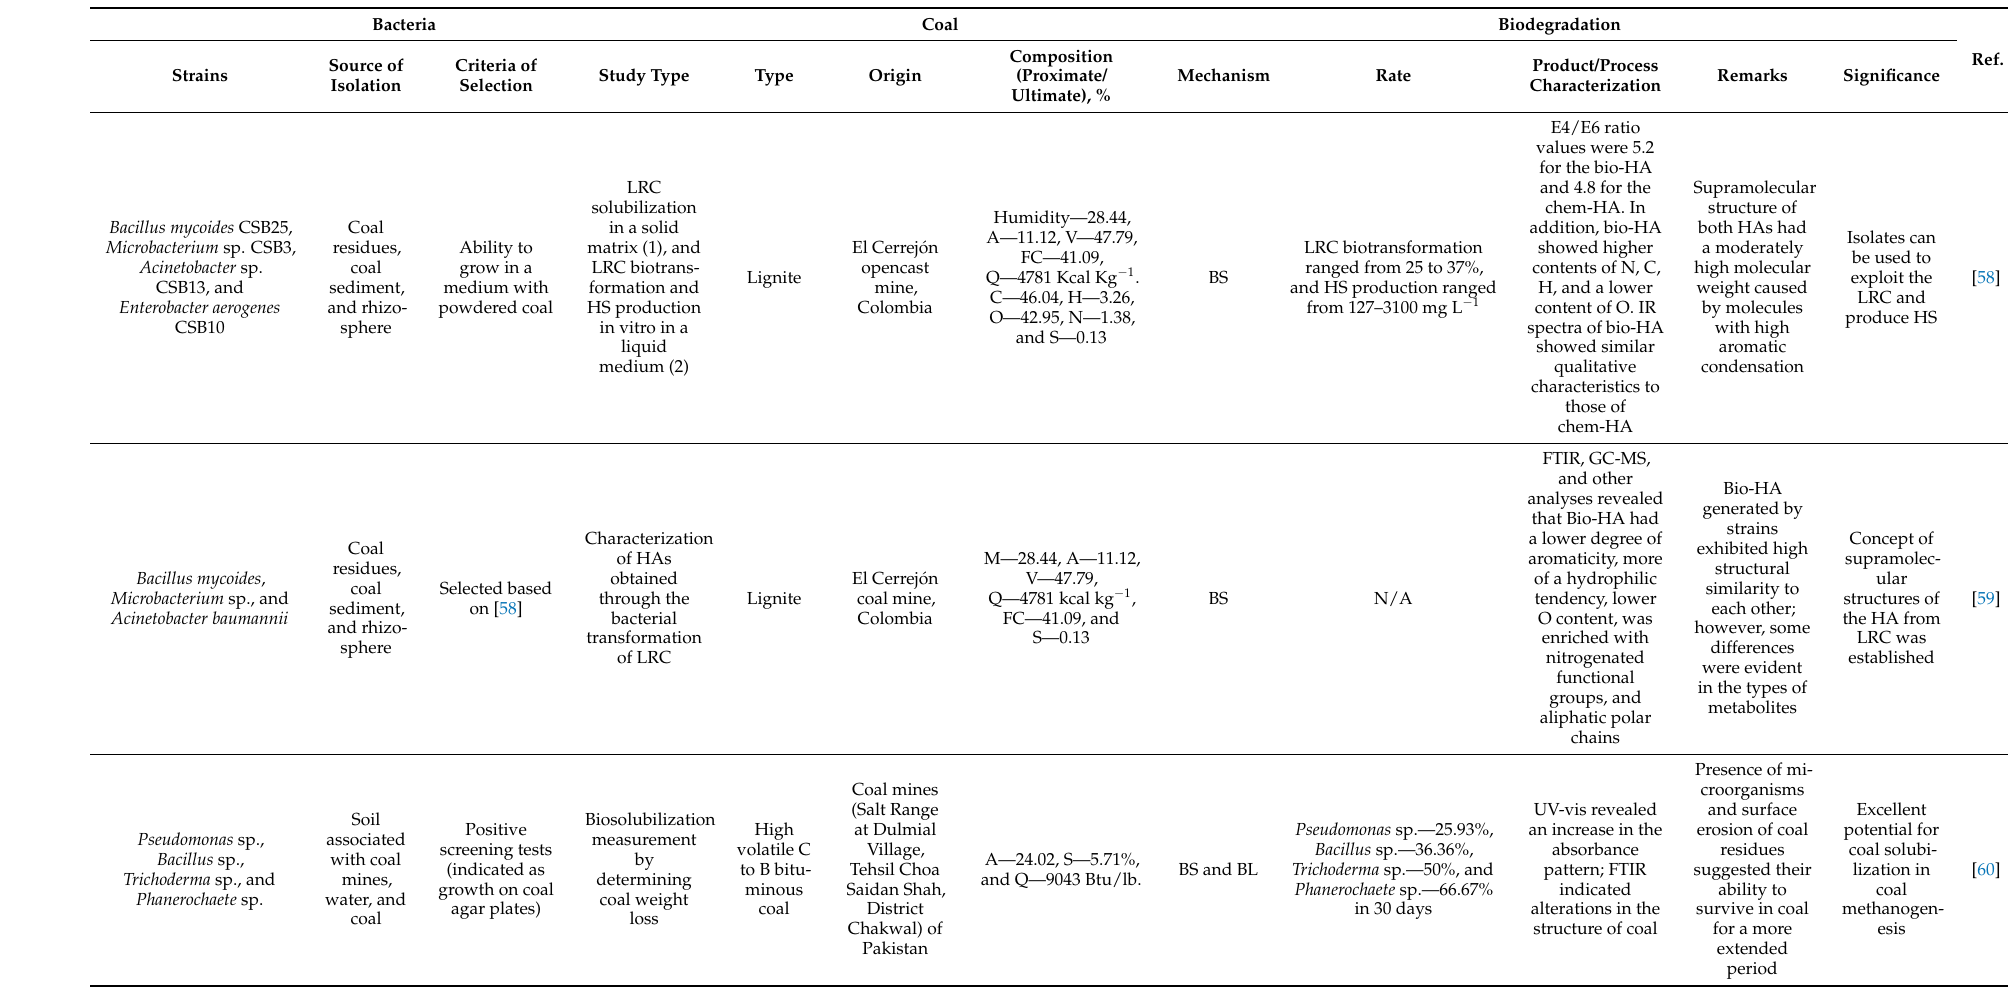
Table 2. Biodegradation of various coal sources through native consortia of bacteria: understanding the mechanisms, rates, and characterization of coal biodegradation is fundamental in the context of coal utilization/processing. This table considers only studies published since 2002